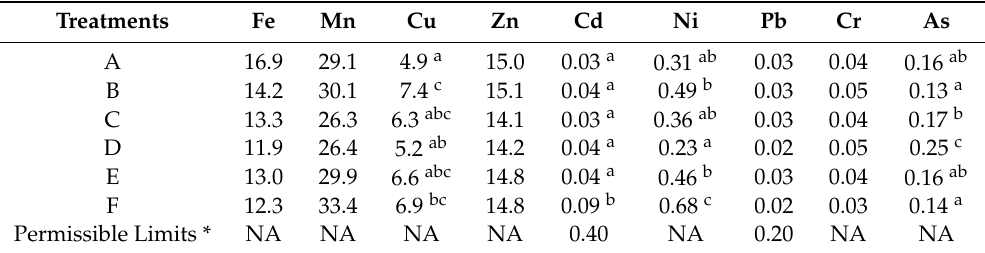
Table 7. Concentrations (mg kg − 1 ) of heavy metals in brown